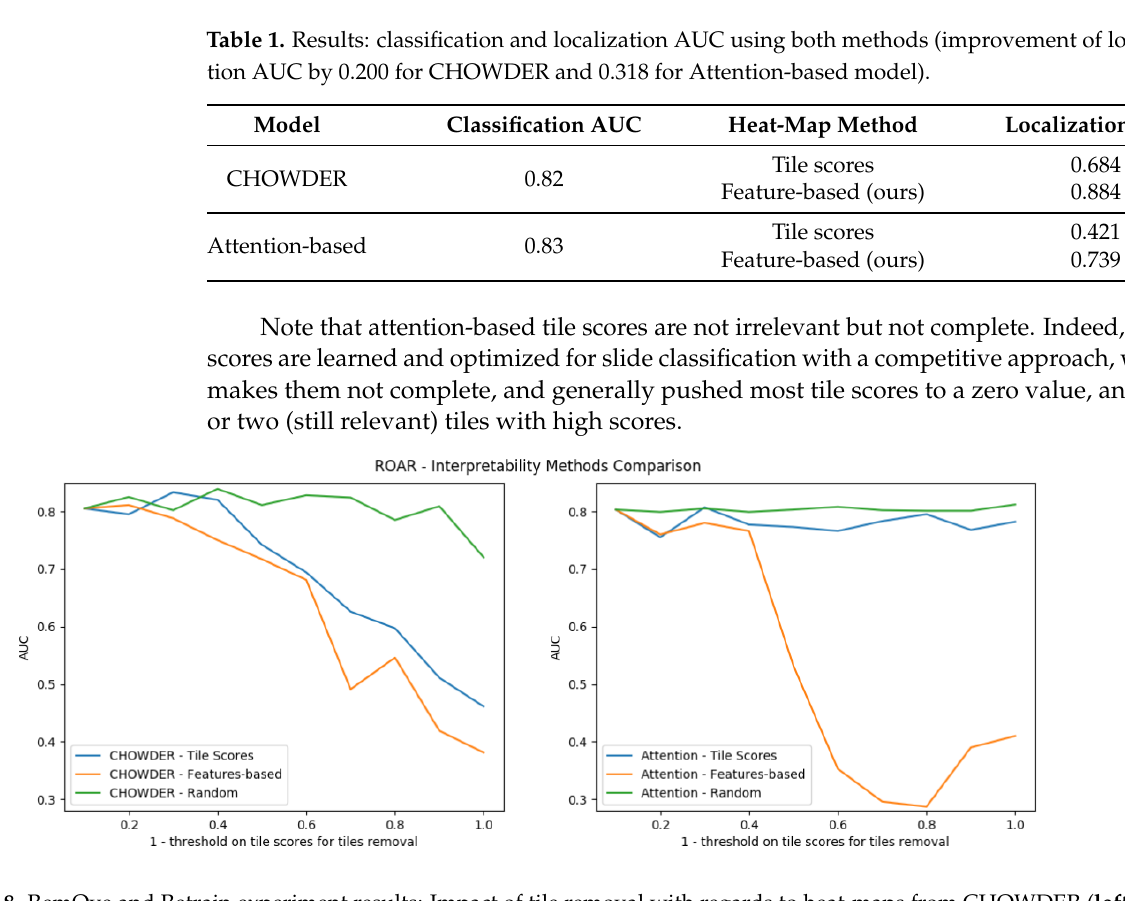
Figure 8. RemOve and Retrain experiment results: Impact of tile removal with regards to heat-maps from CHOWDER ( left ) and Attention-based model ( right ) on slide classification